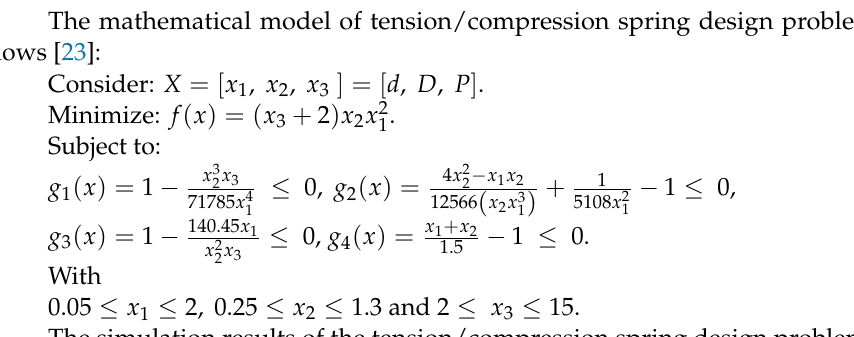
Figure 14. Schematic of the tension/compression spring design.